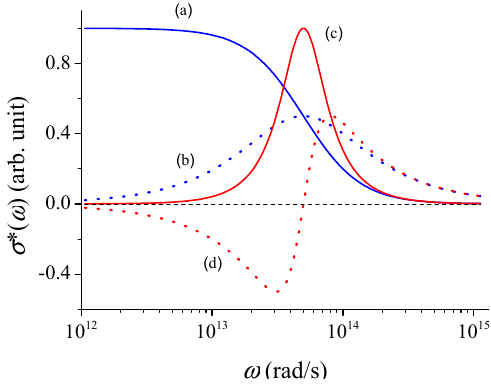
Figure 1. Optical conductivity in the Drude relaxation (( a ) and ( b )) and in the Lorentz resonance (( c ) and ( d )).